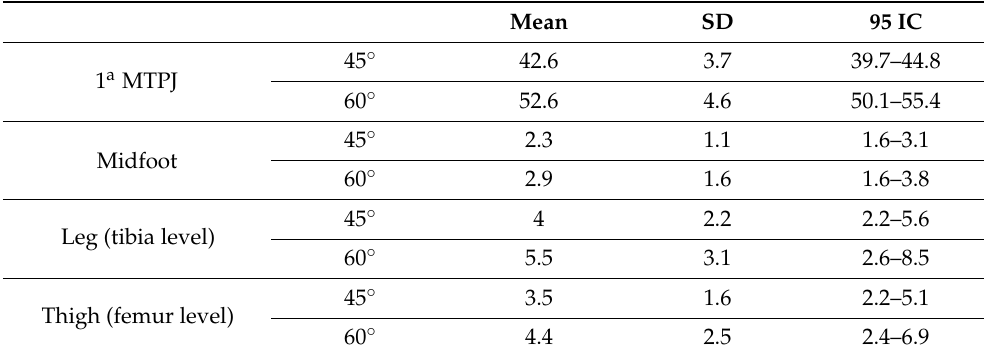
Table 2. Descriptive analysis of the inertial sensor system according to joint extension (1 a MTPJ) at 45 ◦ or 60 ◦ . All variables are measures in degrees. 1 a : first.